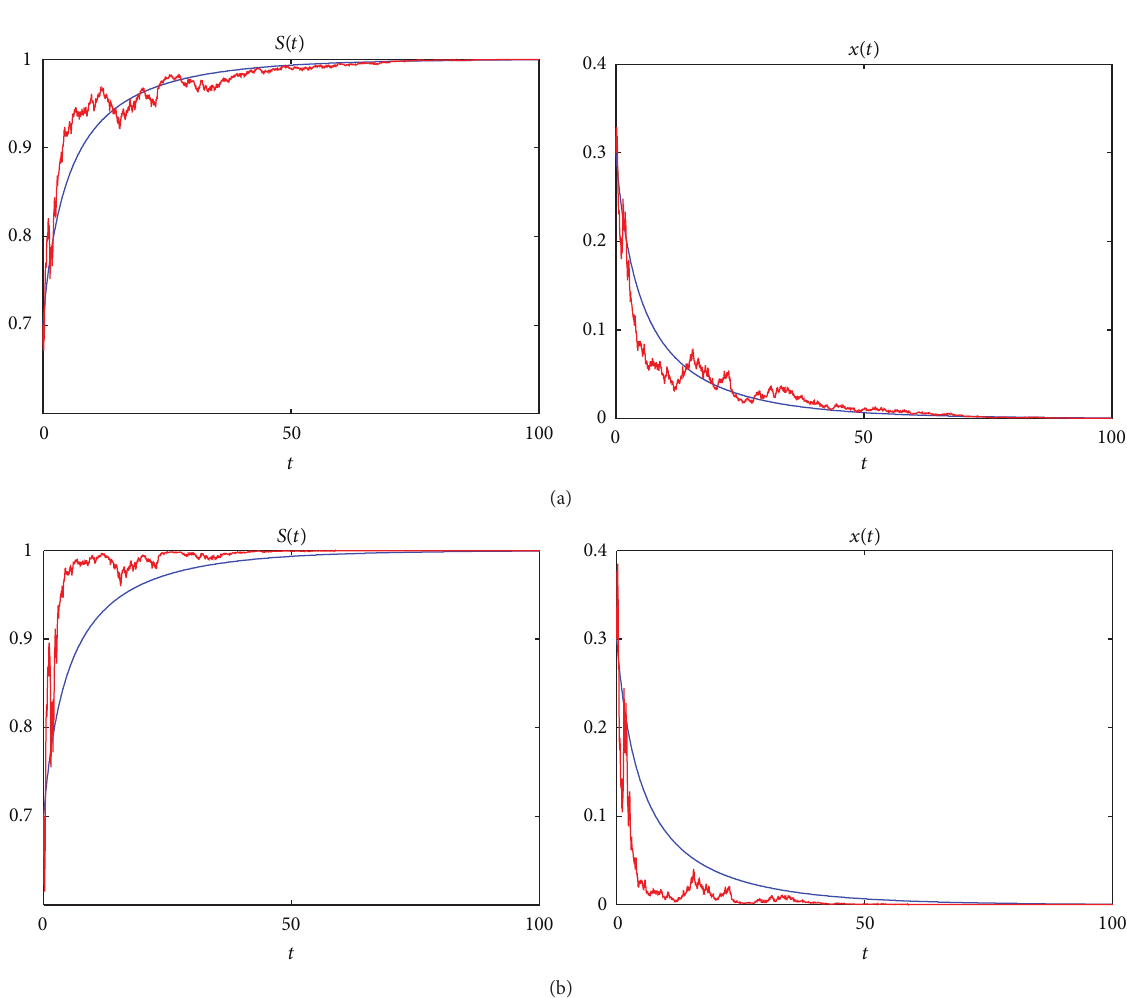
Figure 1: Deterministic and stochastic trajectories of simple chemostat model for initial condition 𝑆 0 = 0.7 ; 𝑥 0 = 0.3 ; and 𝑆 0 = 1 , 𝑚 = 2 , 𝑎 = 0.6 , and 𝐷 = 1.3 . (a) 𝛼 = 0.2 , (b) 𝛼 = 0.5